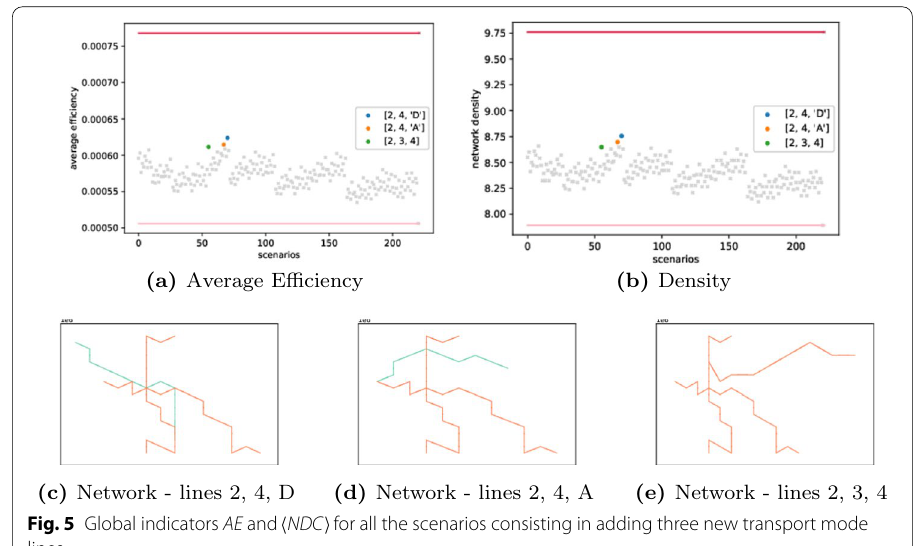
Fig. 5 Global indicators AE and (cid:31) NDC (cid:30) for all the scenarios consisting in adding three new transport mode